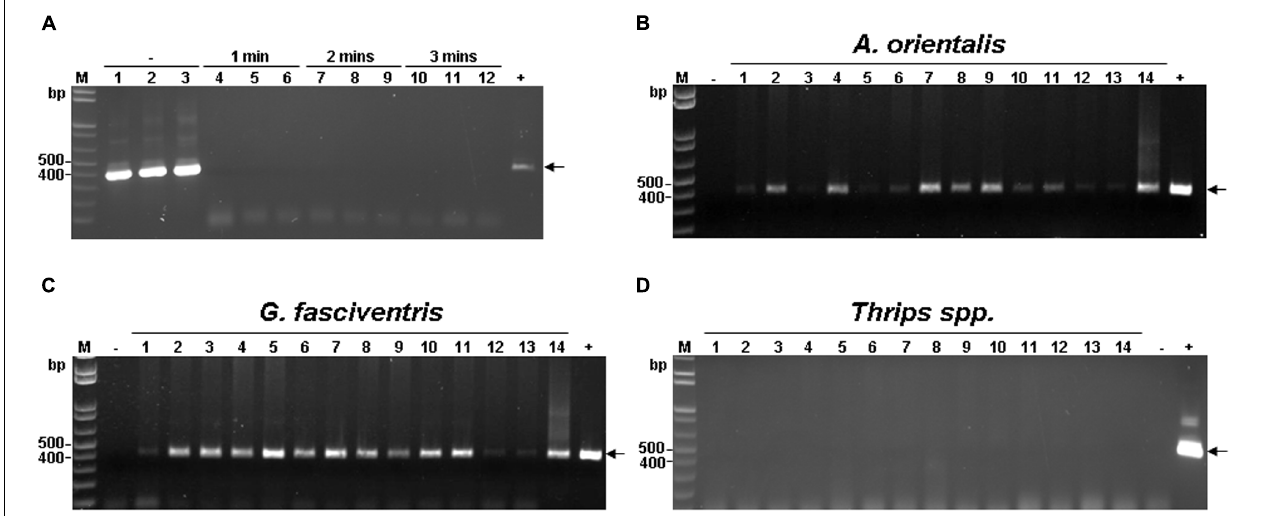
FIGURE 2 | Detection of BaMV RNA in insects collected from BaMV-infected bamboo plantation. (A) Determination of RNase-Away treatment time. See Section “Materials and Methods” for details. Briefly, BaMV-coated G. fasciventris individuals were treated with RNase-Away for 1–3 min as shown on top of the lanes, or untreated (as indicated by the “ − ” sign), rinsed thoroughly and tested for presence of BaMV by RT-PCR by primers B-5981R and B-6366 ( Table 1 ). The expected position of BaMV-specific products is indicated by the arrow. (B–D) Detection of BaMV RNA in insect samples by RT-PCR using the same condition as in (A) . Lane M, 1 kb ladder size marker; lanes 1 through 11, A. orientalis (B) , G. fasciventris (C) or Thrips spp. (D) samples; lanes 12, 13, surface and inner tissues of bamboo shoots, respectively; lane 14 bamboo leaf sample collected from BaMV-infected plantation. The plasmid pCB (1 ng, Yang et al., 2007) and total nucelic acids from BaMV-free bamboo samples were used as positive and negative controls (lanes + and – ), respectively.